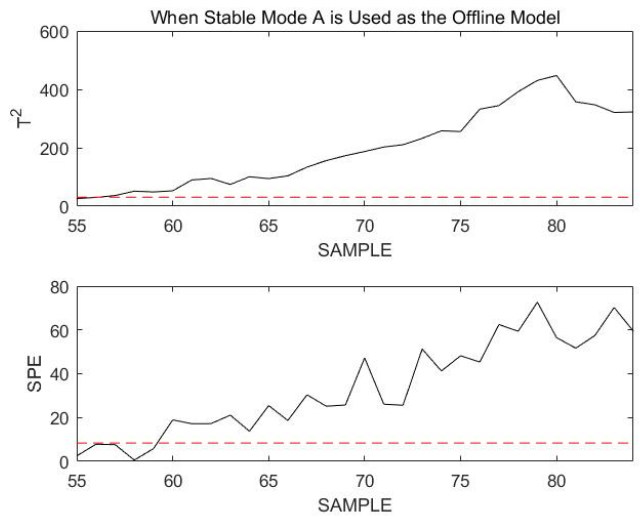
Figure 11. Monitoring 55th to 84th sample points using stable mode A as an offline model.